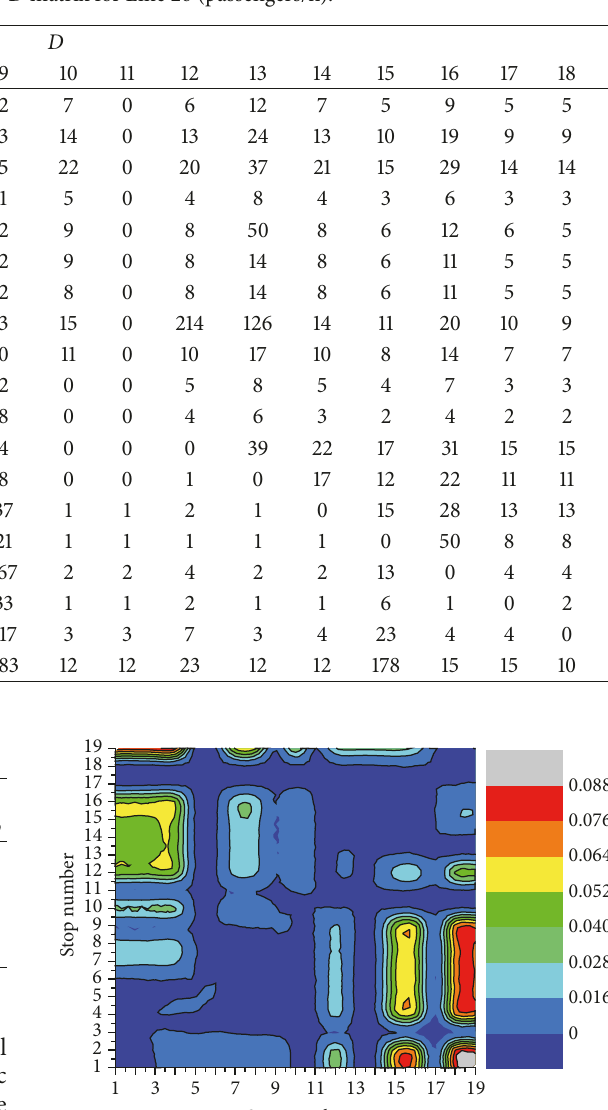
Table 3: Potential passenger O - D matrix for Line 26 (passengers/h).